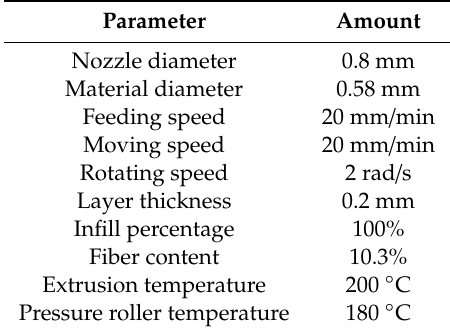
Table 2. The parameters of printing CCFRPs.